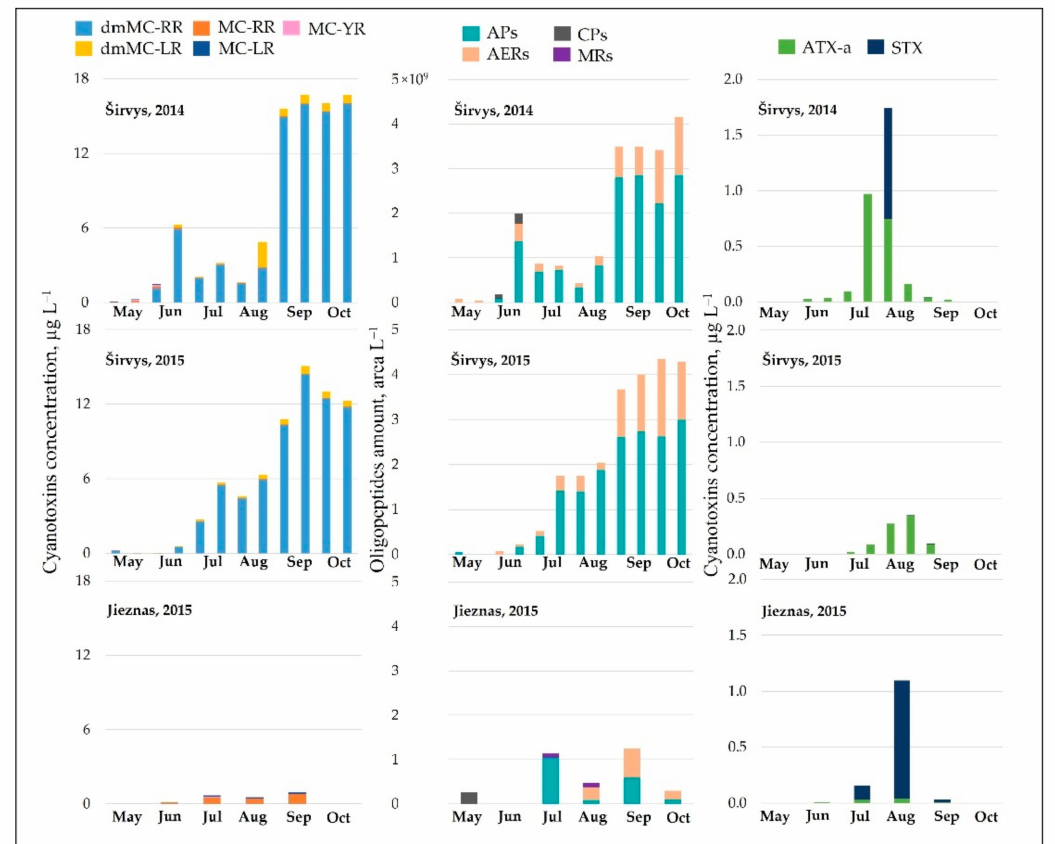
Figure 2. The variation of intracellular cyanometabolites in the field samples of Širvys (monodomi- nant) and Jieznas (polidominant)